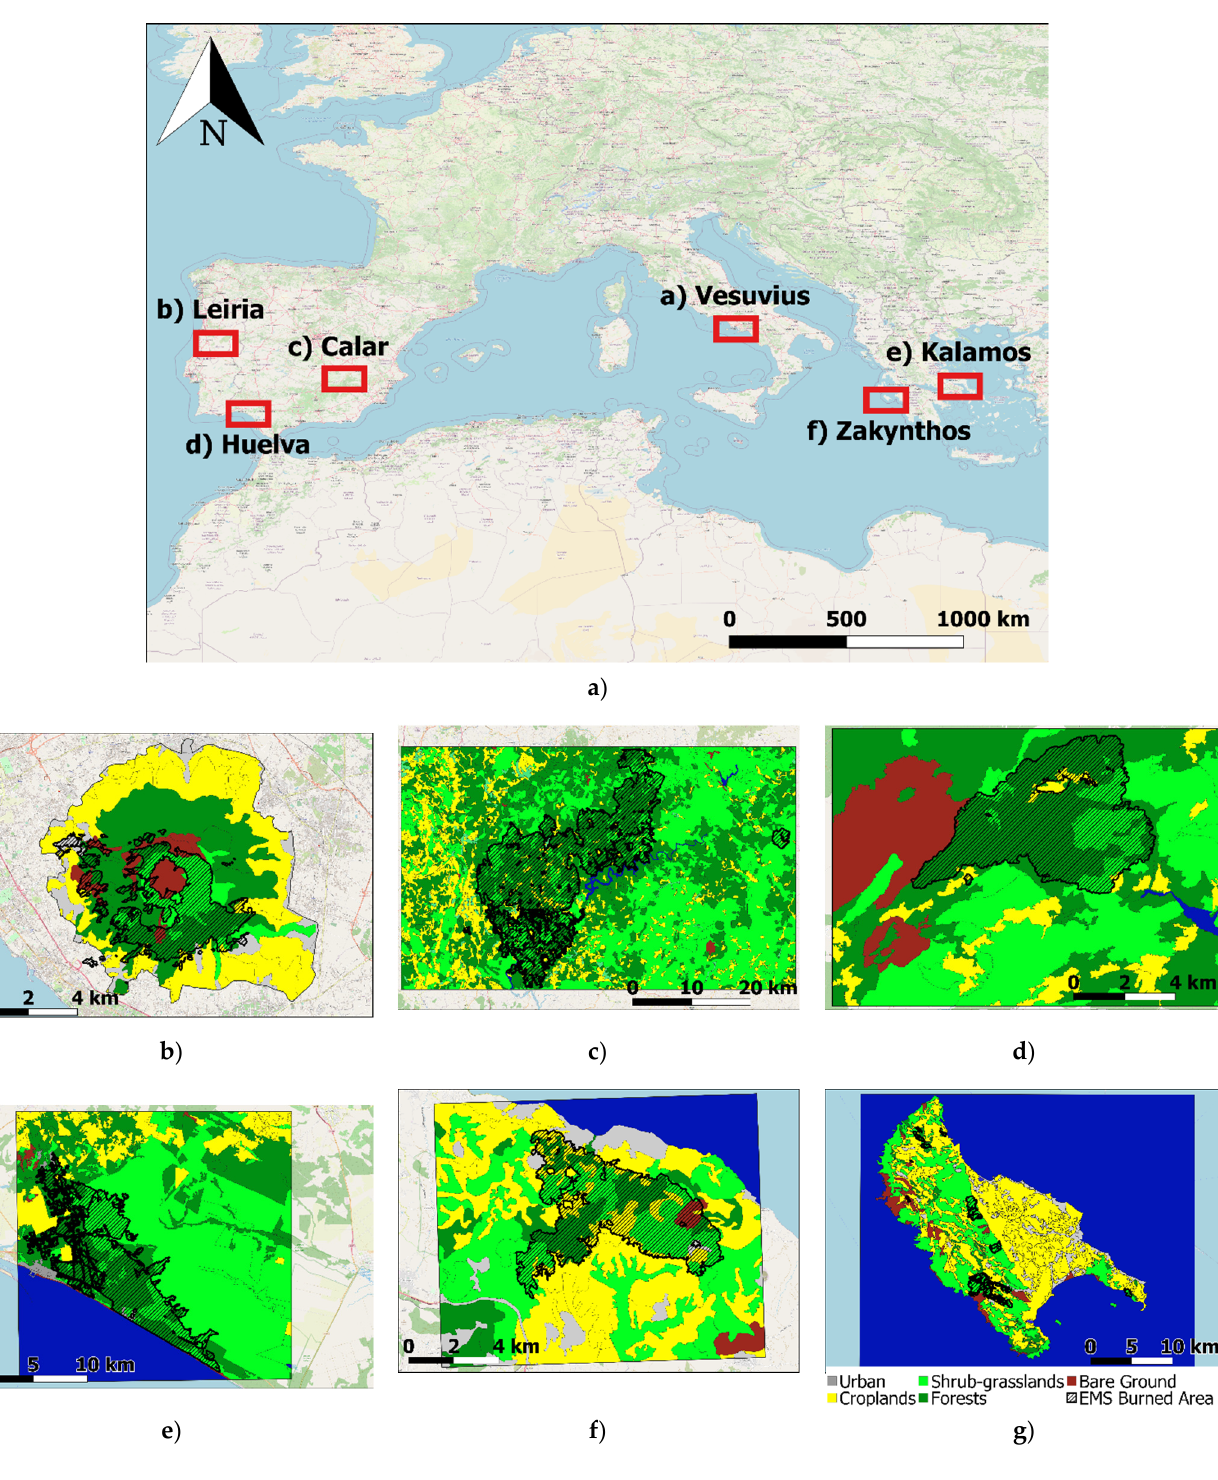
Figure 1. The CLC2012 land cover classes over the six sites located in Southern Europe ( a ): Vesuvius, Italy ( b ), Leiria, Portugal ( c ), Calar, Spain ( d ), Huelva, Spain ( e ), Kalamos, Greece ( f ), Zakynthos, Greece ( g ). Table 1. CLC2012 land cover classes over the entire site and within fire perimeter identified by EMS. In the last column, the proportions of fire damage levels in the burned area according to EMS fire grading products (CD = Completely De- stroyed, HD = Highly Damaged, MD = Moderately Damaged and ND = Negligible to Slightly Damaged), where available.